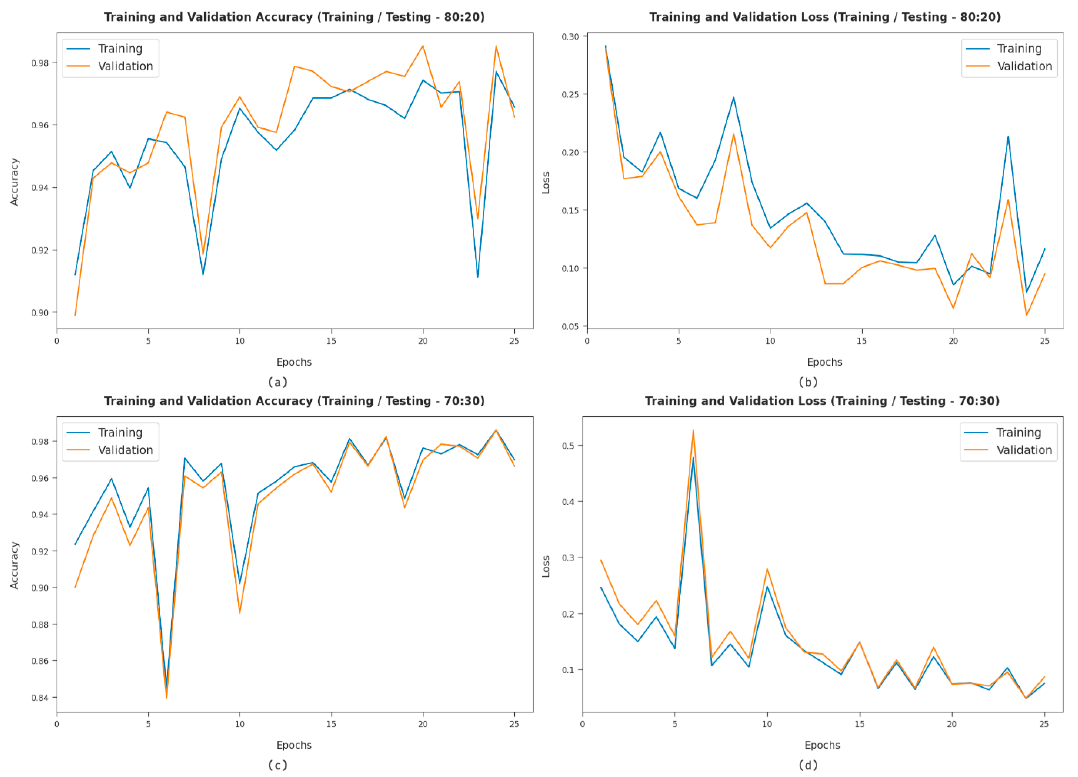
Figure 7. Accuracy and loss analysis of EADL-BTMIC technique ( a ) 80:20 of TR/TS accuracy, ( b ) 80:20 of TR/TS loss, ( c ) 70:30 of TR/TS accuracy, and ( d ) 70:30 of TR/TS loss.